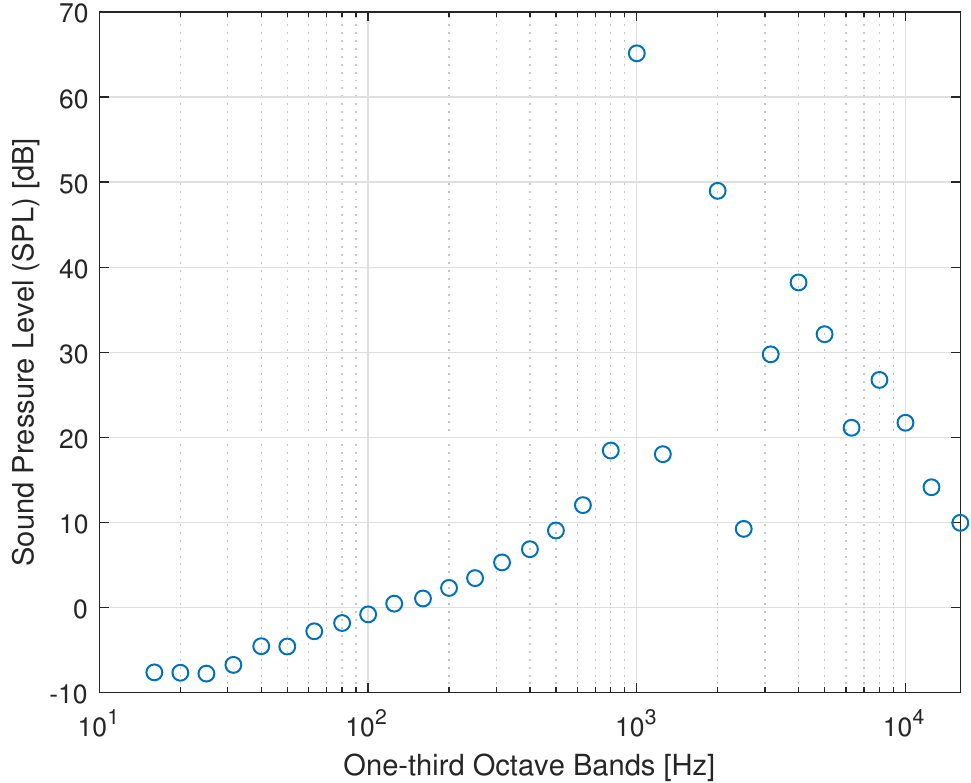
Figure 16. NLR7301 loading noise one-third octave bands at azimuthal position of 90 ◦ .